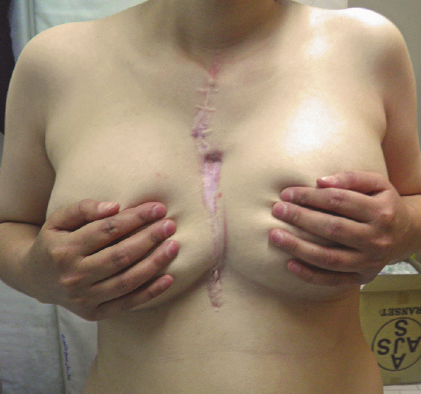
Figure 5: About 18 months after sternal resection there is no evidence of tumoral lesion with small keloid tissue in incisional